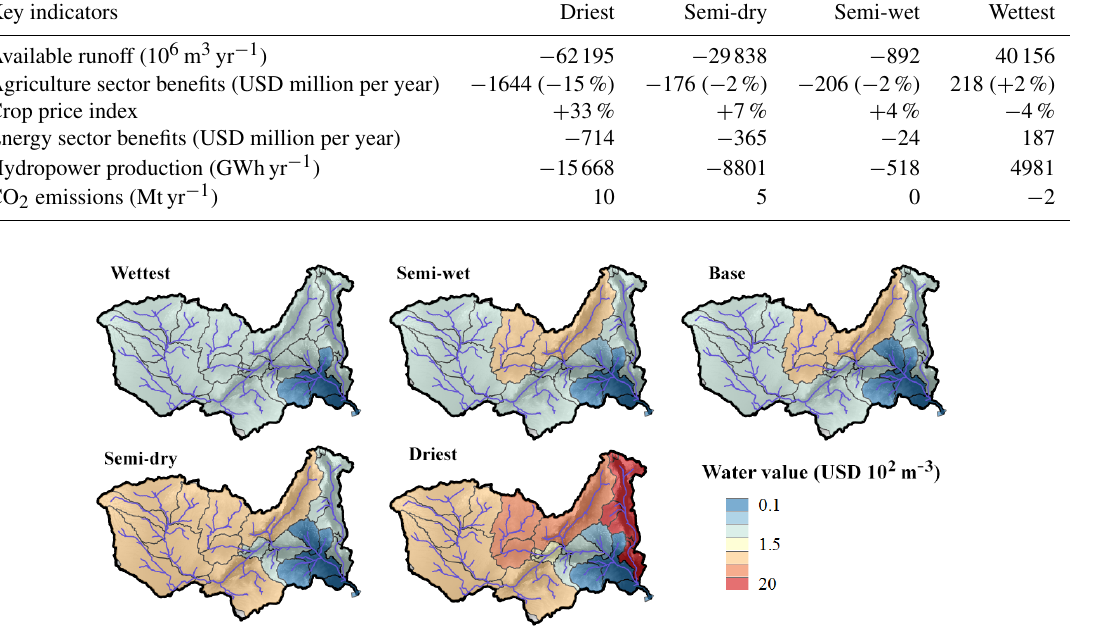
Table 9. Impact of climate change on the water–energy–food system. The results show the difference in key indicators with and without the four climate change scenarios for the 2030 scenario without infrastructure development plans. Key indicators